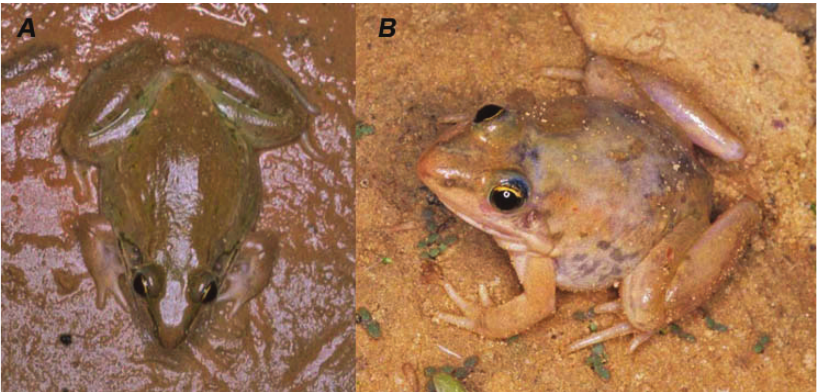
Figure 2. Different individuals of Ptychadena schillukorum from Aleg, Mauritania. Museum number of photographed specimens: A MNCN 42210 (SVL = 32.7 mm) B MNCN 42221 (SVL = 27.3 mm) (photos Rafael Márquez).